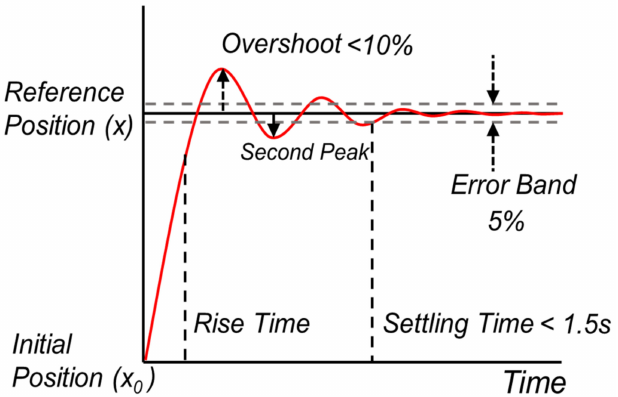
Figure 2. Ideal criteria for acceptable response